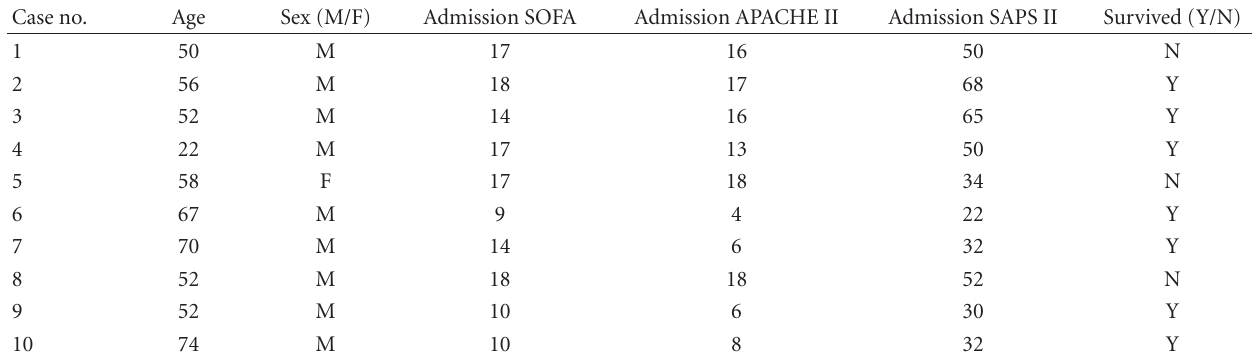
Table 3: SOFA, APACHE II and SAPS II on ICU